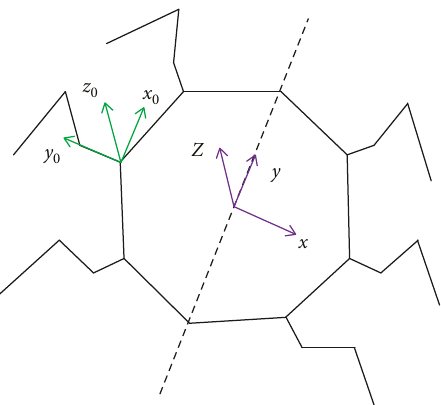
Figure 3: The body coordinate system and the leg coordinate